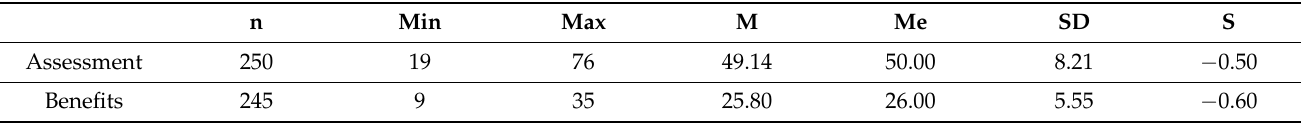
Table 9. Descriptive statistics for the summary assessment of the development of the transport system and benefits of developing an